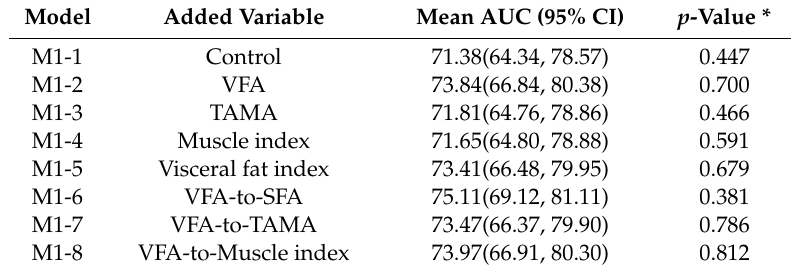
Table 3. Comparison of body composition variables to predict surgical site infection after gastrectomy using receiver operating characteristic